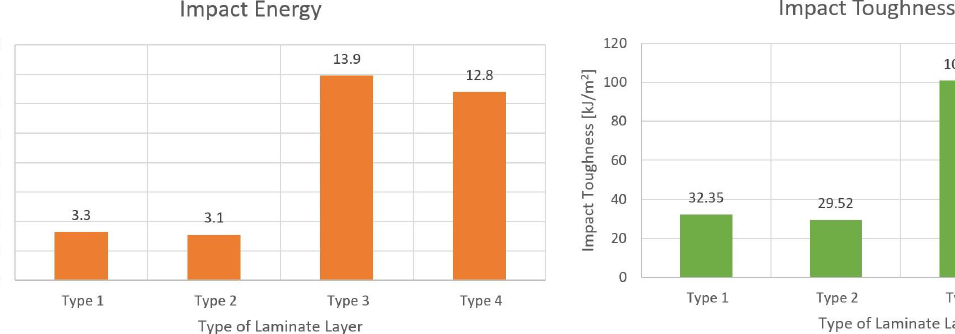
Figure 13: Impact toughness of HCGFRP in each lamina configuration